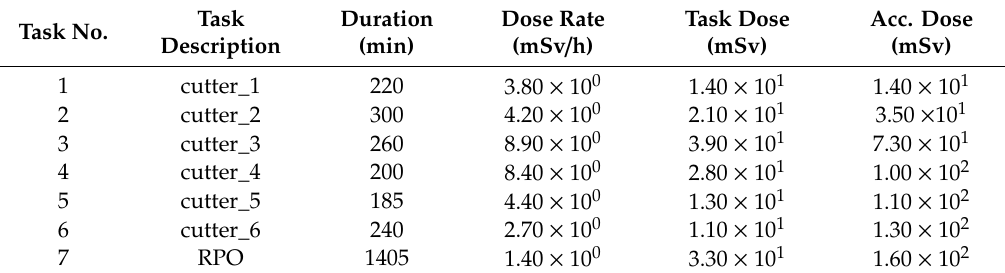
Table 10. Task information for the segmentation of upper